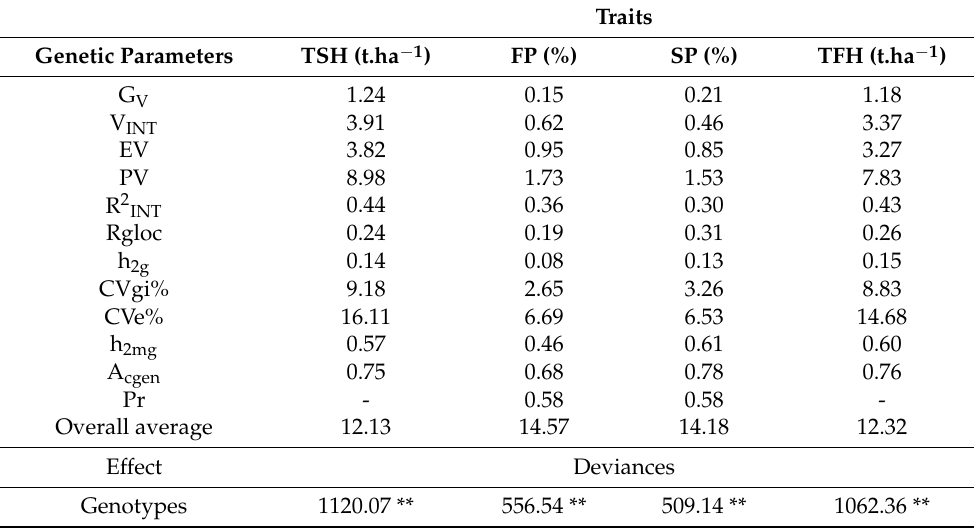
Table 2. General average, estimates of the variance components and genetic parameters of the traits tons of sucrose per hectare (TSH), fiber percentage (FP), sucrose percentage (SP) and tons of fiber per hectare (TFH) of the sugarcane genotypes, evaluated in experiments conducted in the five sugarcane microregions of the state of Pernambuco, considering two harvest cycles. Traits